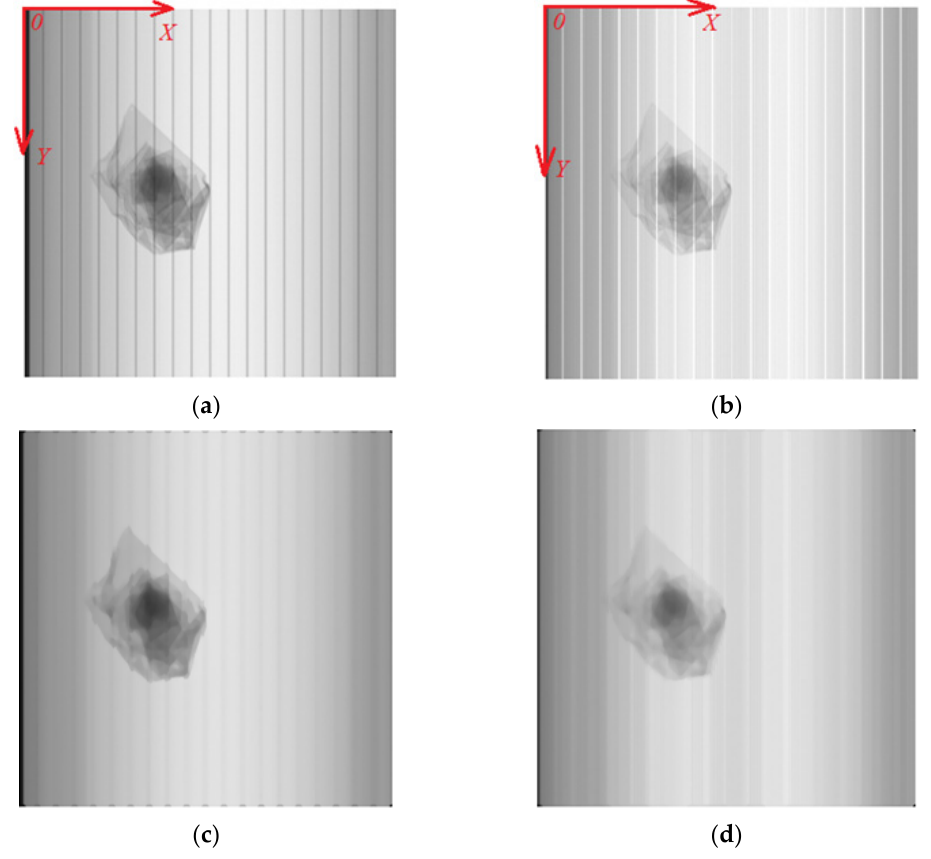
Figure 7. ( a ) Raw low-energy image; ( b ) raw high-energy image; ( c ) low-energy image with filtering; ( d ) high-energy image with filtering.